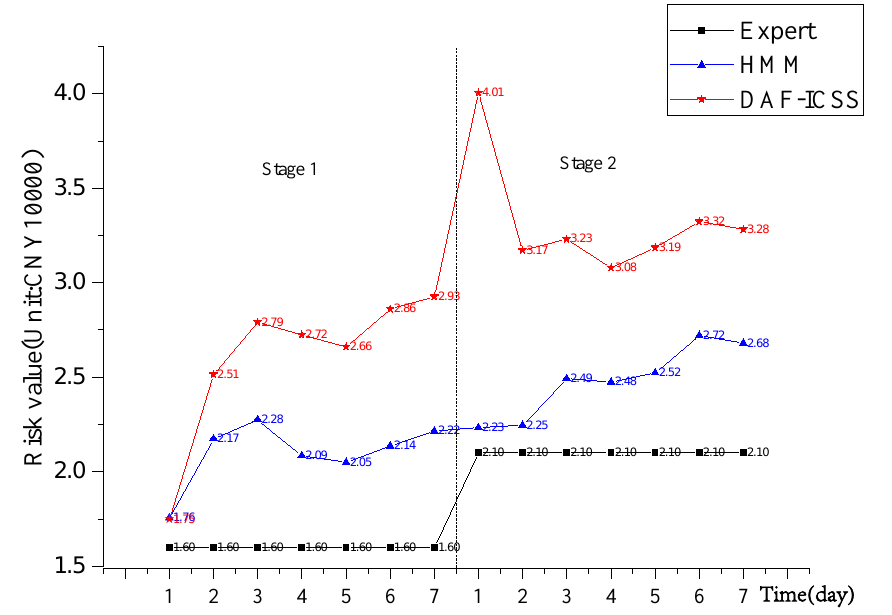
Figure 9. The result of the experiment.